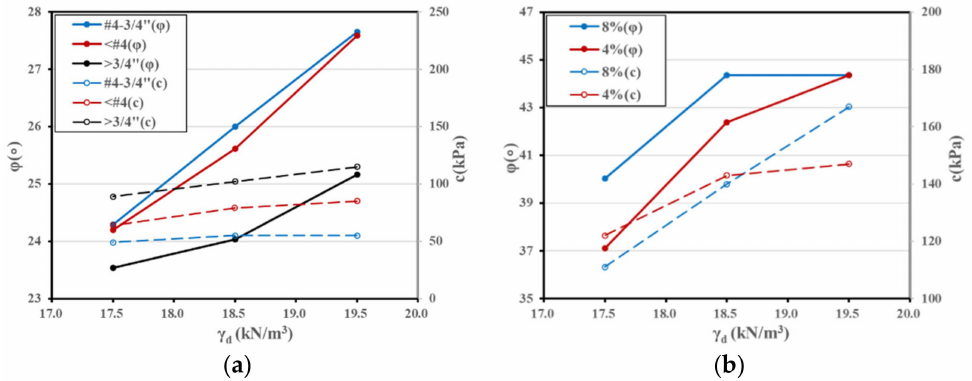
Figure 13. Cohesion values and internal friction angles of the samples for triaxial Consolidated Undrained tests: ( a ) mudstone; ( b )